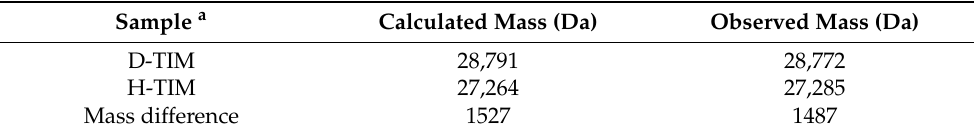
Table 3. Intact mass MS analysis of proteins isolated from cells grown in DD-M9 (recrystallized pyruvate- d 3